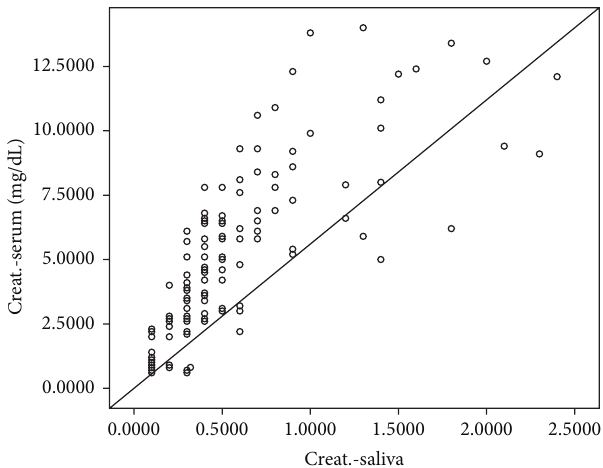
Figure 2: Scatter plot showing serum and salivary levels including both cases and